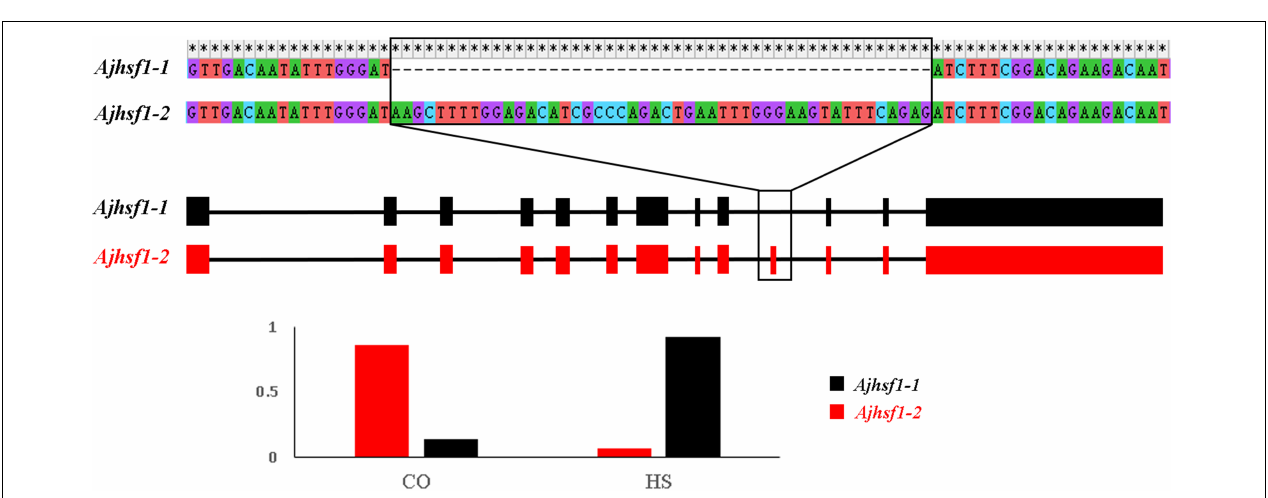
FIGURE 6 | The alignment of exon 10 and flanking regions in Ajhsf1-1 and Ajhsf1-2 isoforms. Exon 10 is spliced out in the Ajhsf1-1 isoform, whereas it is retained in the Ajhsf1-2 isoform. The boxes represent the exons and the line represents the introns. Bar graph showing the relative mRNA levels for the two isoforms in CO and HS